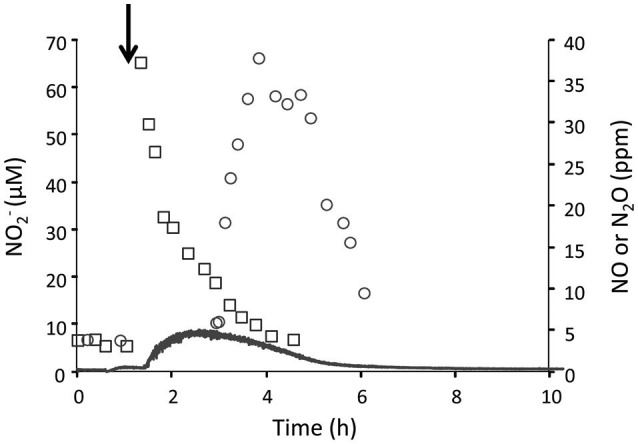
Cells from the CH4/NO3- continuous culture (0.6 L; D = 0.026 h−1; OD600 = 1.3; O2 limited) perform denitrification when nitrite was added to the reactor vessel. The concentrations of NO2- (open rectangles), NO (solid line) and N2O (open circles) were measured before and after addition of 50 μM NO2- (arrow). Duplicates of individual values do not deviate more than 5 and 10% for NO2- and N2O, respectively.